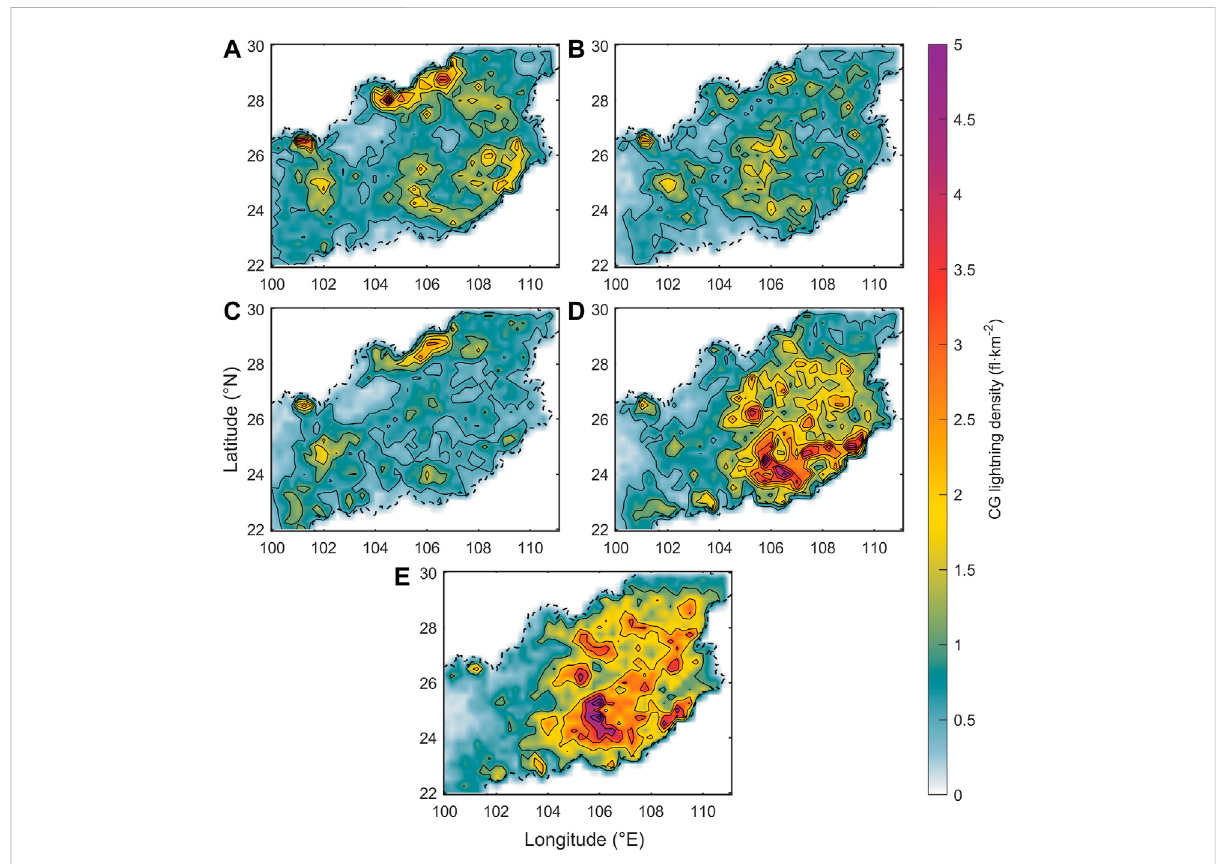
FIGURE 3 The inter-annual variation of the spatial distribution of the lightning density on the Yungui Plateau from 2016 to 2020: (A) 2016, (B) 2017, (C) 2018, (D) 2019, and (E)